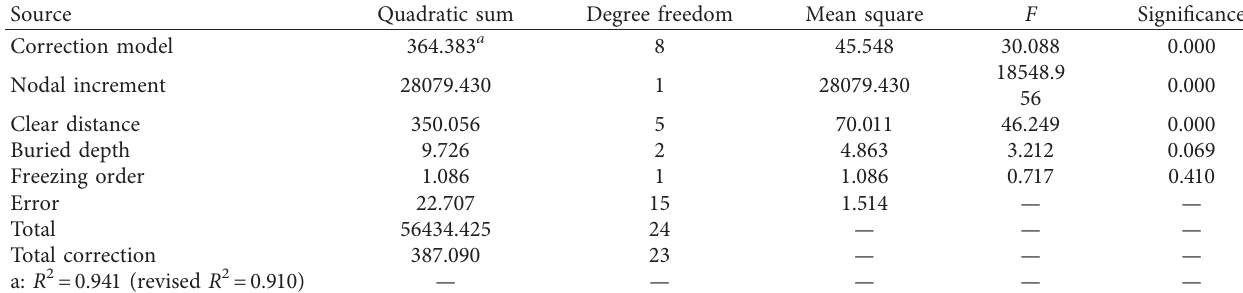
Figure 10: Heaving displacement of the ground surface. Table 4: Significance analysis of three factors.